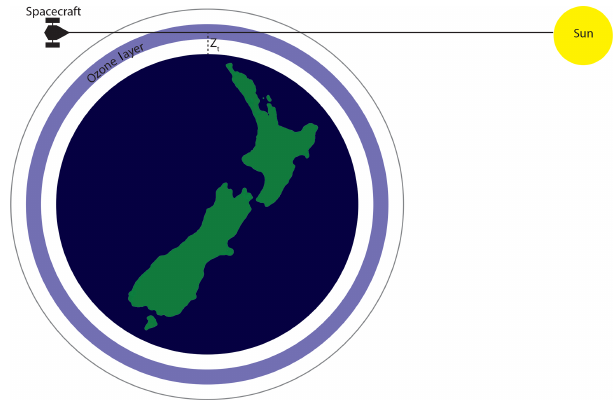
Figure 1. A schematic diagram showing the solar occultation view- ing geometry that is exploited by SAGE II to make measurements of atmospheric constituents. Z t denotes the tangent altitude. For more details, see the main